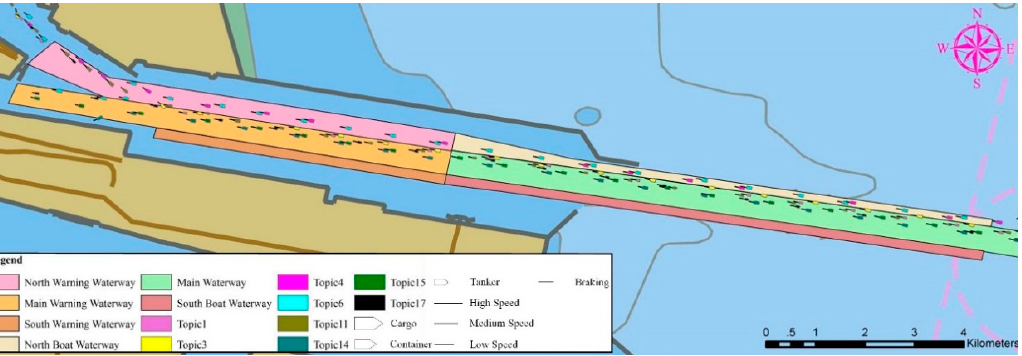
Figure 14. Visualization of the spatial distribution of 8 motion pattern topics entering the Tianjin port waterway.